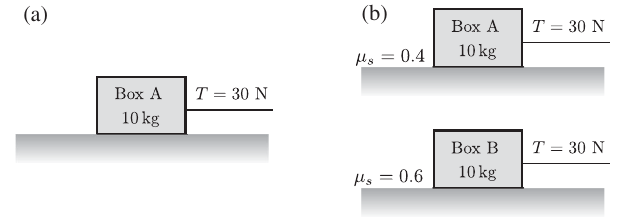
FIG. 1. Diagrams given to students for (a) the screening question and (b) the target questions of the two-box friction